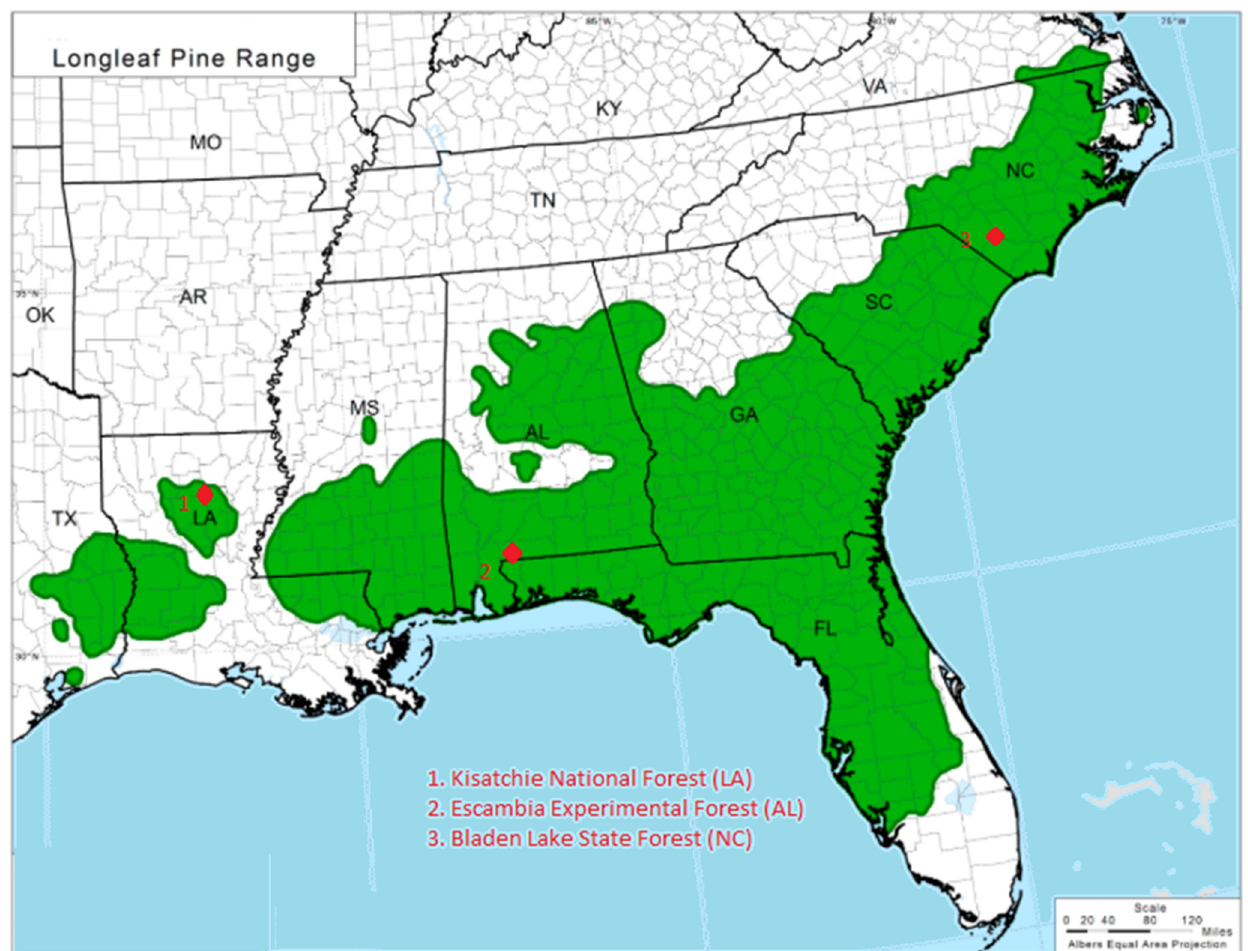
Figure 1. The historical range of longleaf pine forests and locations of three study sites (the original map is from USDA).